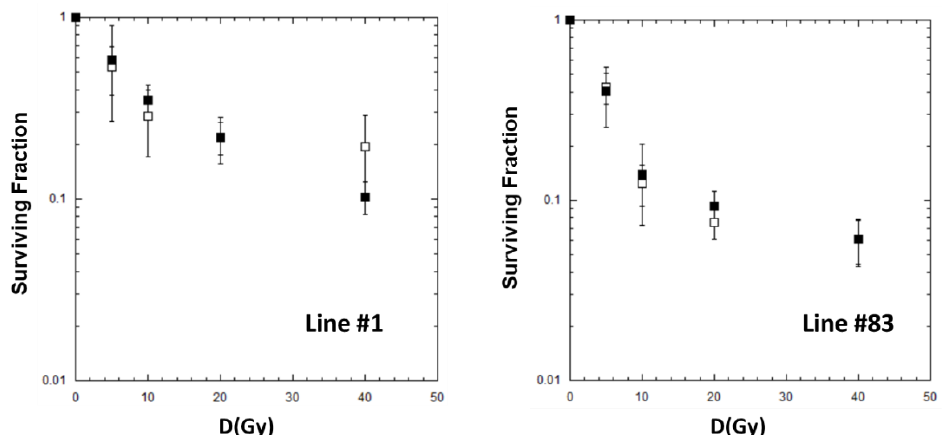
Figure 2. Dose–response curves for GSC cells irradiated in FFF conditions at different dose rates: 4 Gy/min (solid square), 24 Gy/min (open square). The error bar represents the standard error of the mean (SEM) coming from at least 2 independent experiments for each irradiation condition used.